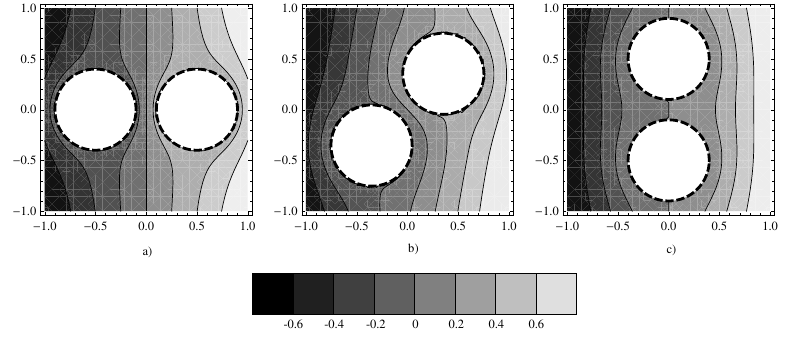
Figure 2. Two disks in the uniform external field expressed by the potential x for various locations of the centers with δ = 0 . 2. Data are for the potential Re ϕ ( z ) and the constant u 0 calculated with (2.20) and (2.21): a) a 2 = − a 1 = 1 a 2 = − a 1 = 1 (1 + i ), u 0 = 0 . 212132; c) a 2 = − a 1 = i √ 2 2